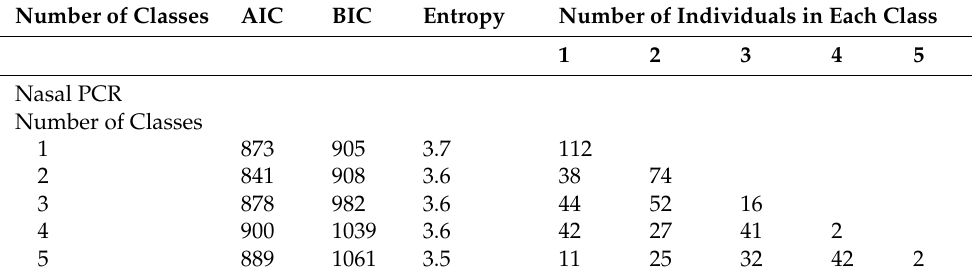
Table 2. Fit statistics for latent class analysis demonstrating a two-class model as the best fit for this